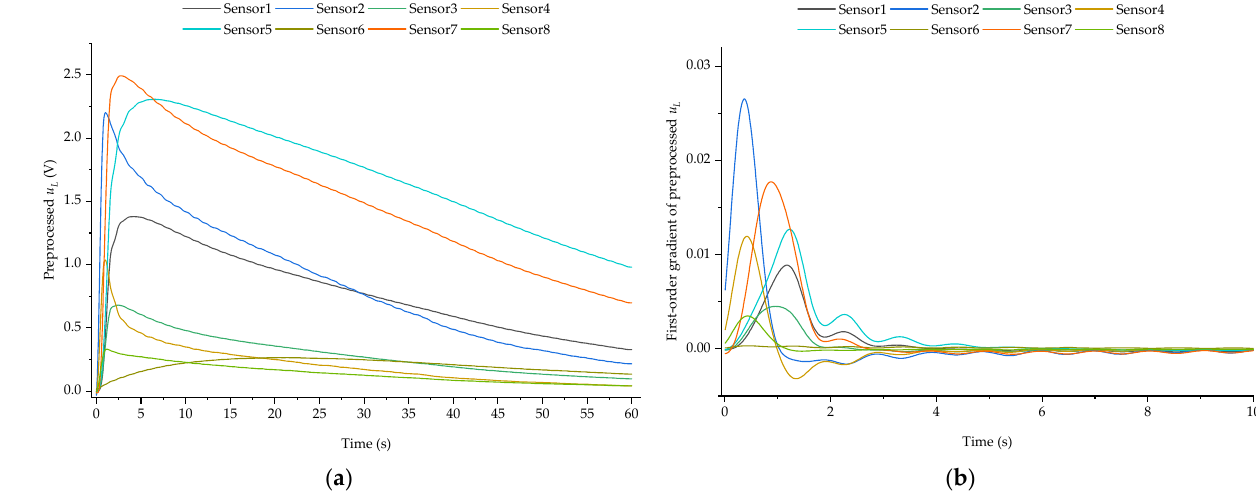
Figure 9. Typical values obtained in an individual cycle of liquor sampling. ( a ) The value of prepro- cessed u L ; ( b ) The first-order gradient of preprocessed u L in the first 10 s of a liquor sampling cycle.